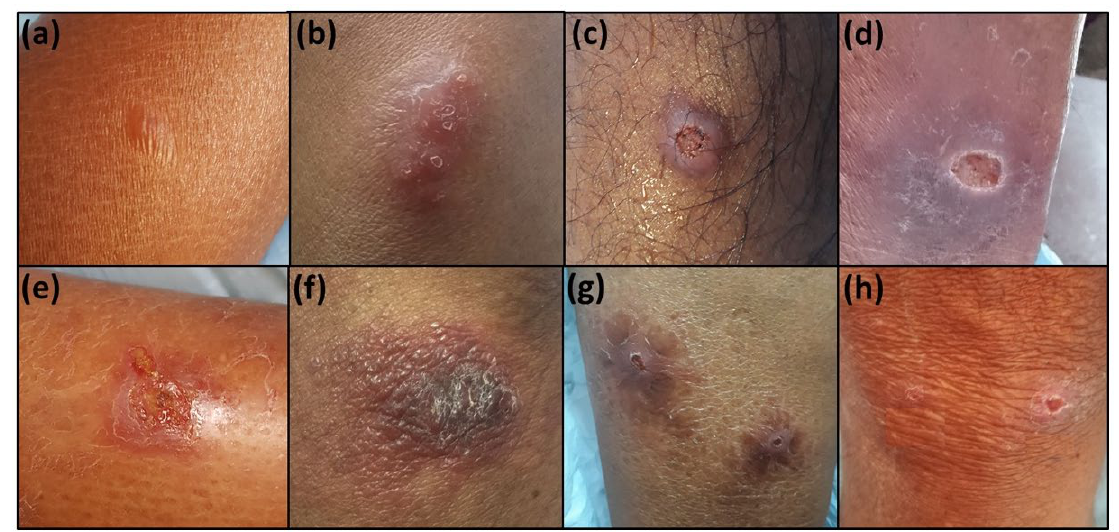
Figure 1. The range of clinical lesion types observed: ( a ) papule; ( b ) nodule; ( c ) ulcerated nodule; ( d ) dry ulcer; ( e ) wet ulcer; ( f ) plaque; ( g ); ( h ) multiple lesions.